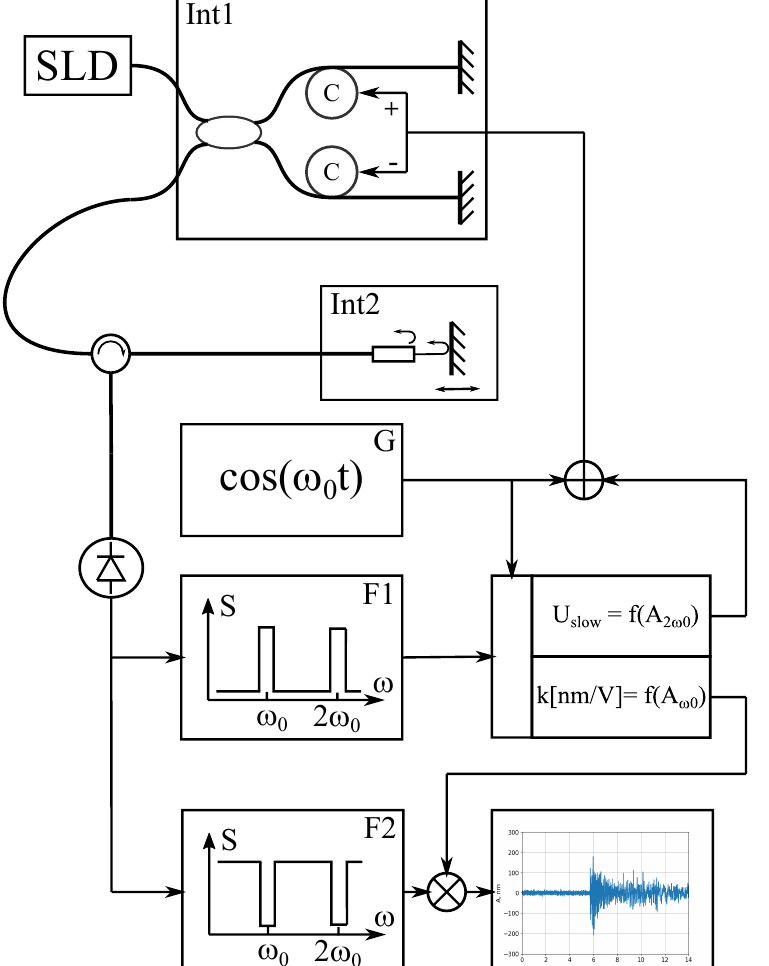
Figure 3. Detection circuit. SLD—superluminescent diode, Int1—reference interferometer, Int2— sensor interferometer, G—generator, F1—bandpass digital filter, F2—bandstop digital